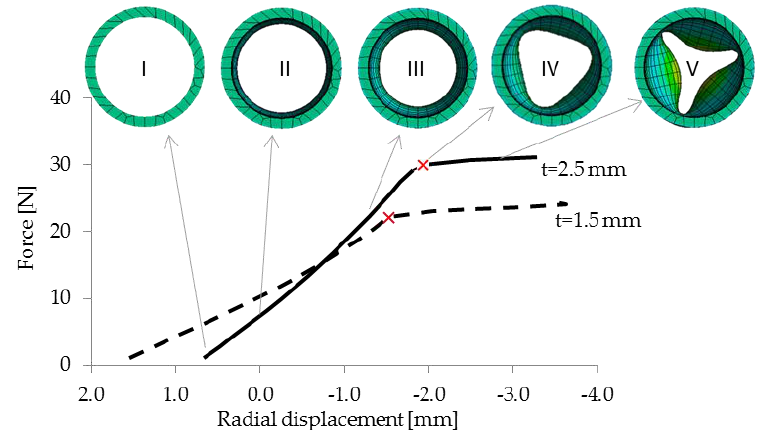
Figure 5. Force/displacement plot for ramped compression forces of elastic aortic wrapping in t = 1.5 mm and t = 2.5 mm. Critical forces which initiate folding are marked with red X. Pictures I-V above illustrate the progression of reduction in diameter with increased compression force for t = 2.5 mm.